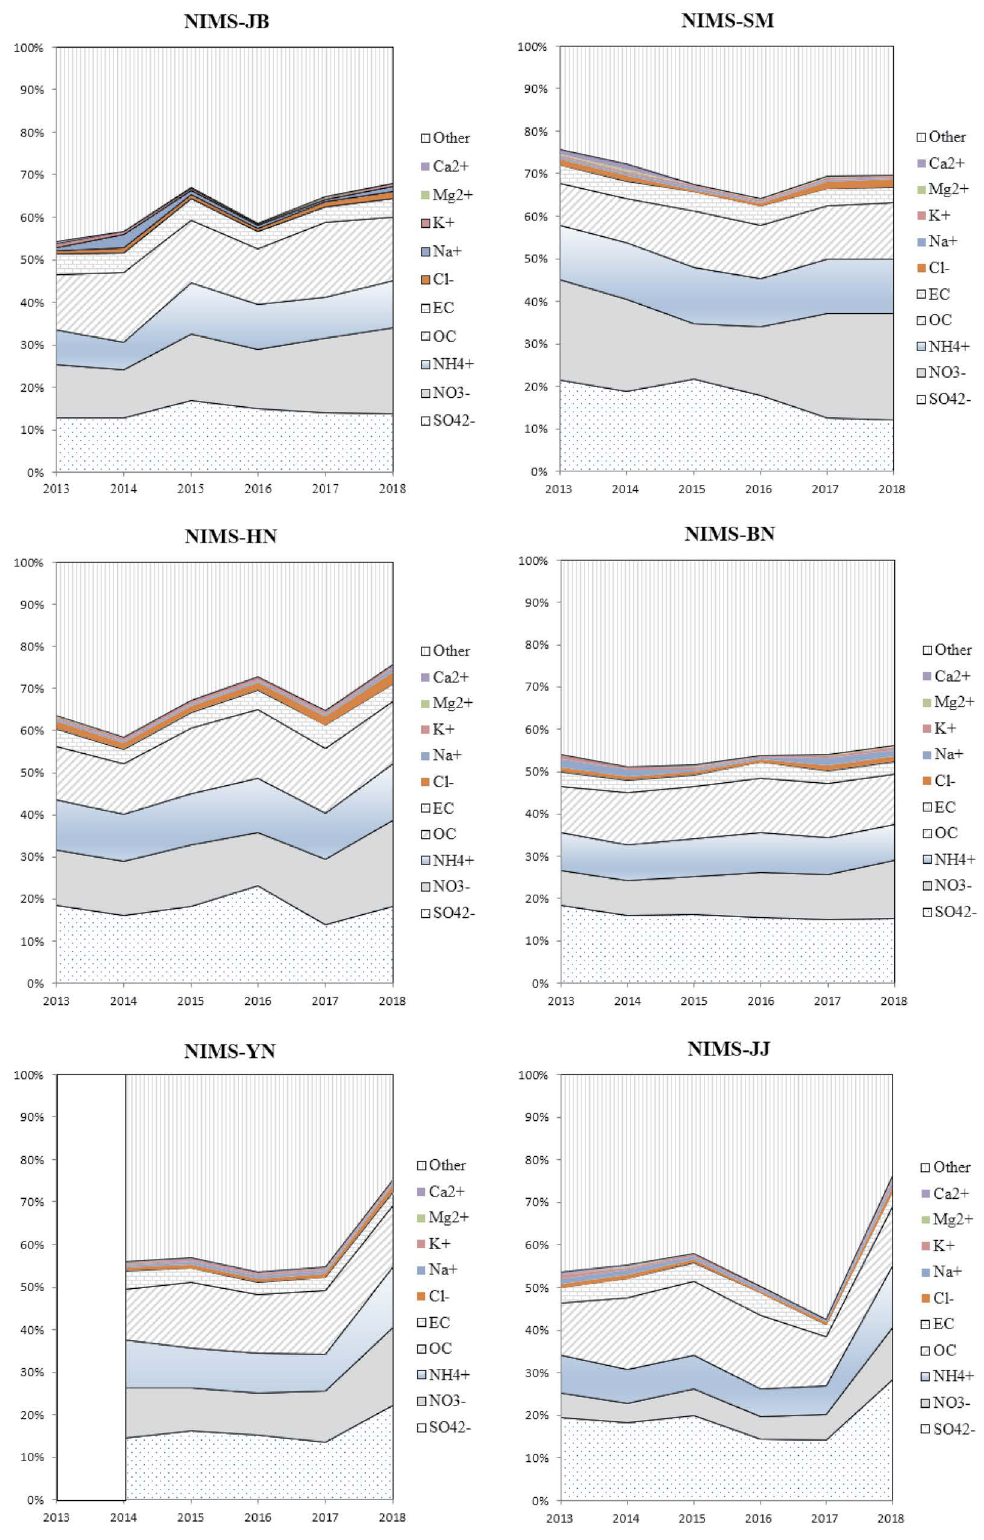
Fig. 8. Stacked plots showing annual trends of 10 chemical compositions as percentage in PM